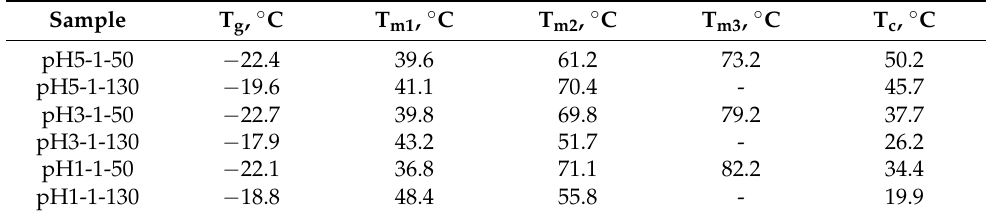
Table 5. Glass transition (T g ), melting (T m1 , T m2 , T m3 ), and crystallization (T c ) temperatures of SA from DSC thermograms.